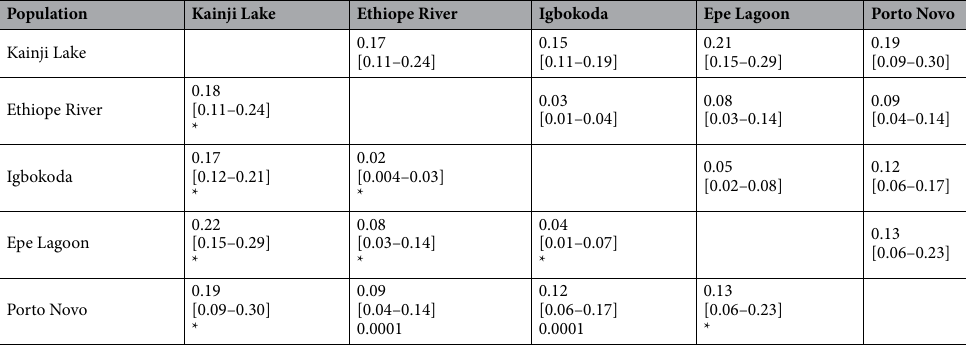
Table 2. Pairwise F ST estimations with (above the diagonal) and without correction for null alleles (95% confidence intervals in brackets; p values below brackets; * = <